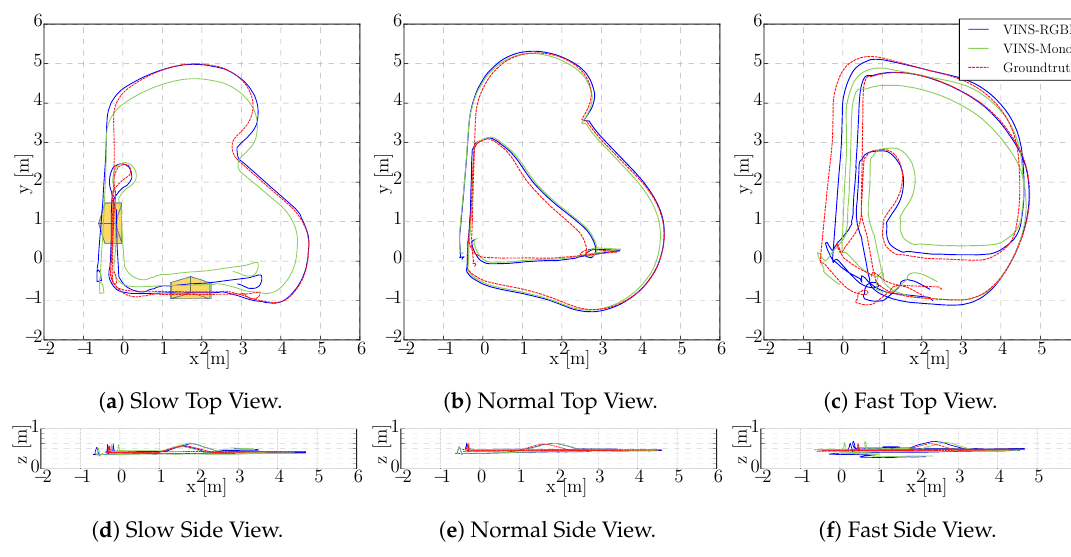
Figure 12. Robot Hardware Platform.